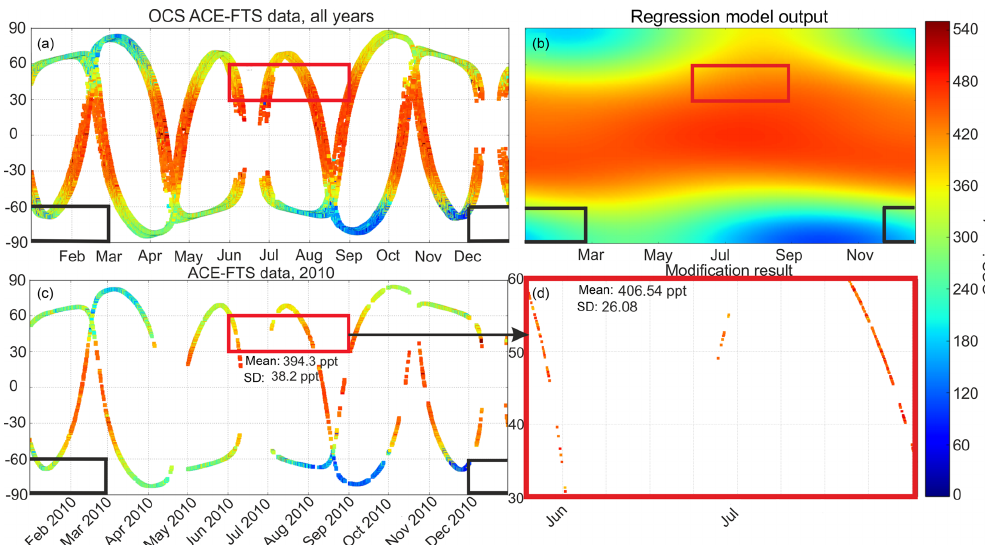
Figure 1. Schematic illustration of how the sampling bias is estimated and adjusted for OCS mean mixing ratio at 16km altitude in any chosen time–latitude bin. Two examples are discussed in more detail in the text and are indicated by the red and black boxes. (a) All ACE-FTS measurements (2004–2016) as a function of day-of-year and latitude. (b) Regression model output to the ACE-FTS data of (a) . (c) ACE-FTS measurements in 2010. (d) “Adjusted” data set, i.e., after the applying Eq. (2) to the ACE-FTS measurements shown in (c) , for the red